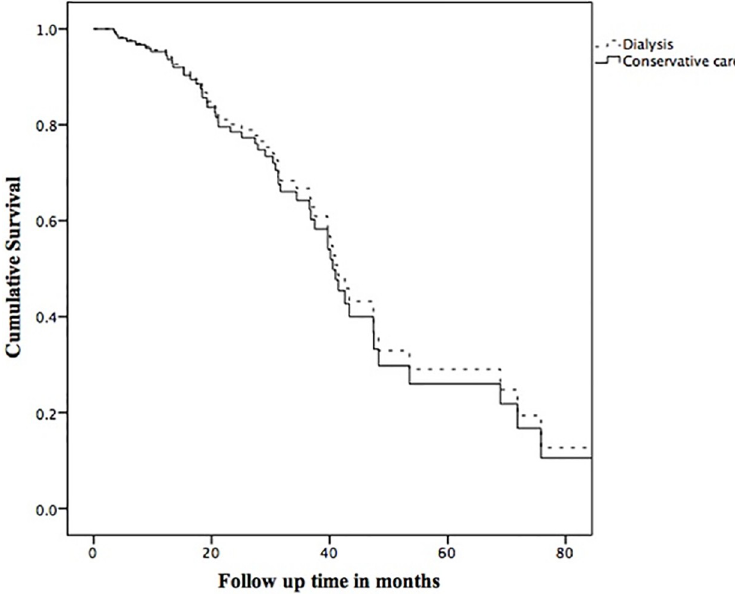
Fig 4. Survival curve comparing dialysis with conservative care during the period that eGFR was between � 15 mL/min/1.73m 2 and > 10mL/min/1.73m 2 . Adjusted for age, peripheral vascular disease, and living alone.